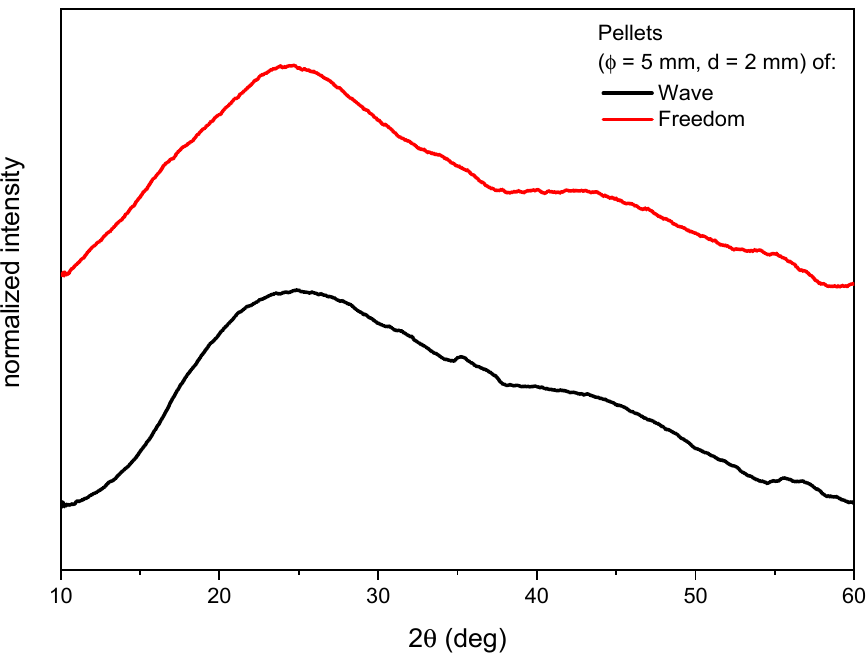
Figure 1. XRD diagrams of studied materials. The study was performed for one randomly selected sample of each material: Wave and Freedom.